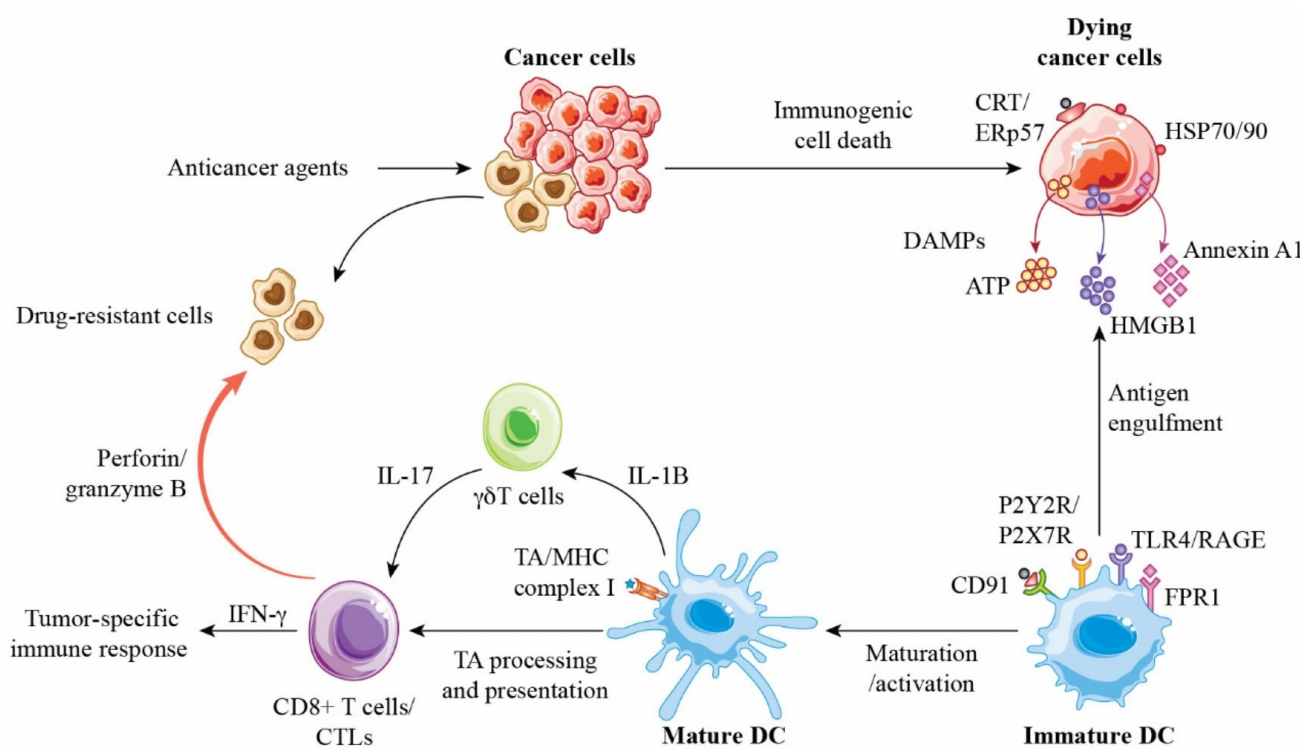
Figure 2. Molecular mechanisms by which immunogenic cell death due to anticancer drugs leads to tumor-specific immune activation. When anticancer drugs are administered, dying tumor cells expose CRT on membrane surfaces in a CRT/ERp57 complex and release DAMPs such as HMBG1, ATP, and annexin A1, which bind to CD91, TLR4/RAGE, P2Y2R/P2X7R, and FPR1, respectively. TAs released from dying cells are engulfed by immature DCs, which are activated and mature. Thereafter, TA and TAA processing proceeds in mature DCs, and TAs and TAAs are presented to CD8+ T cells as MHC complex I molecules, generating CTLs for tumor-specific immune responses. These processes result in IL-1 β - and IL-17- dependent and IFN- γ -mediated immune responses involving γδ T cells and CTLs, ultimately leading to the eradication of drug-resistant tumor cells and allowing for the development of long-term immune memory for a cancer cure. Abbreviations: ER, endoplasmic reticulum; RAGE, receptor for advanced glycation end products; FPR1, formyl peptide receptor 1; MHC, major histocompatibility